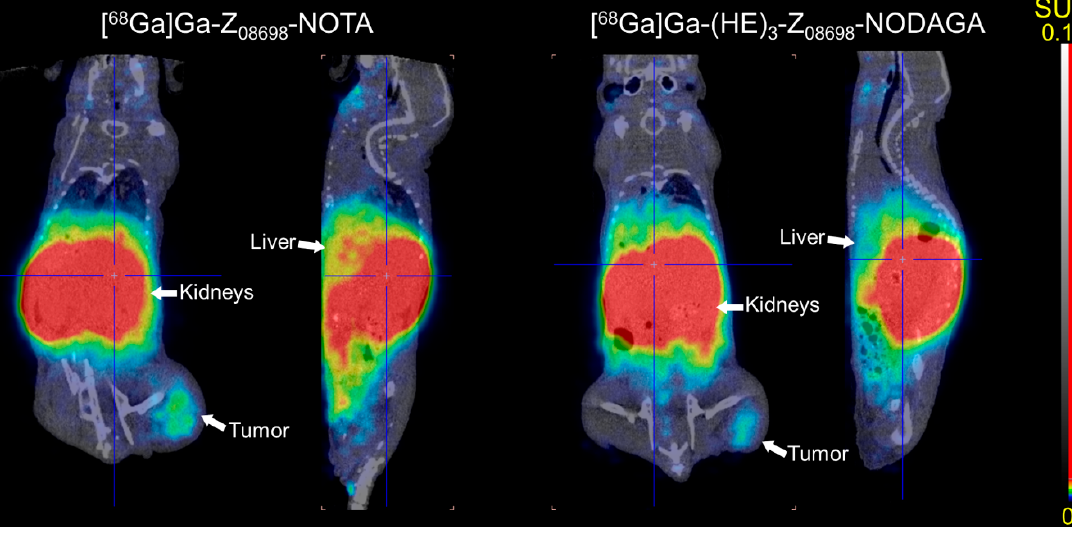
Figure 3. microPET-CT imaging of [ 68 Ga]Ga-Z 08698 -NOTA ( left ) and [ 68 Ga]Ga-(HE) 3 -Z 08698 -NODAGA ( right ) 3 h p.i. Mice bearing BxPC-3 xenografts were injected with 2 µg of the affibody molecules (4.8 MBq for [ 68 Ga]Ga-Z 08698 -NOTA and 7.8 MBq for [ 68 Ga]Ga-(HE) 3 -Z 08698 -NODAGA).